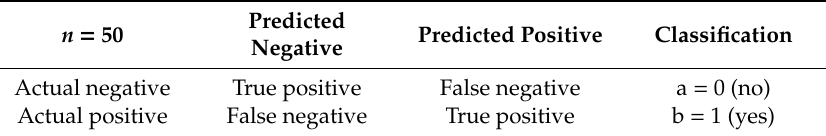
Table 2. WEKA Confusion Matrix explained.